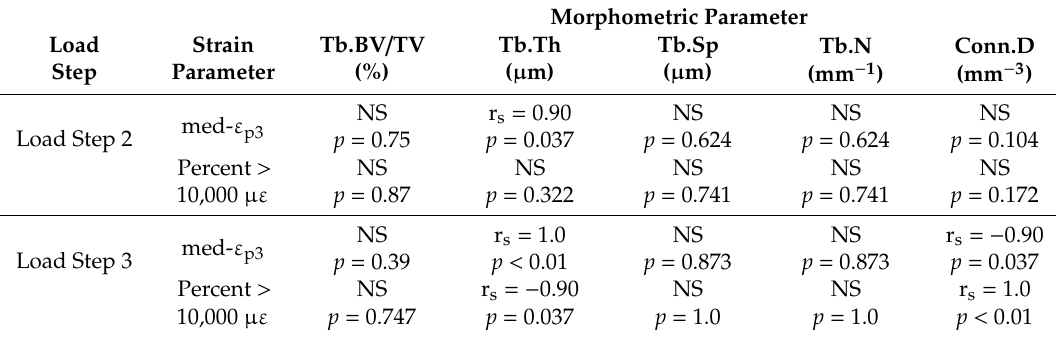
Table 3. Spearman’s rank correlation coe ffi cient for exploring linear associations between strain outputs and morphometric properties ( n =